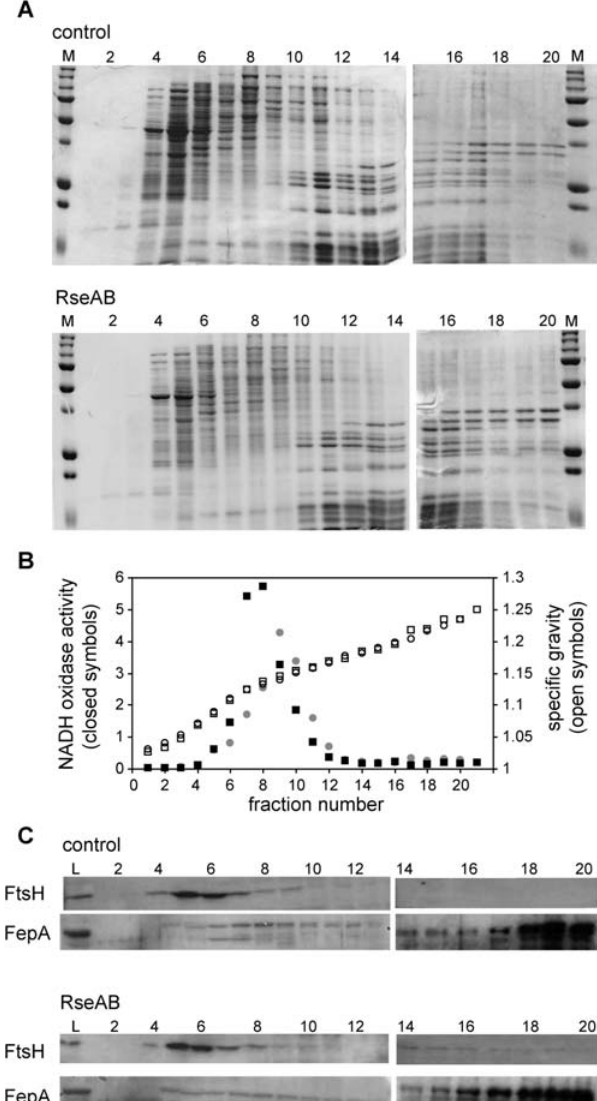
Figure 5. Fractionation of strain SEA007 lysates with and without inhibition of s E on sucrose density gradients. At 2.5 hours following inhibition of s E , cells were harvested and lysates separated by discontinuous sucrose density gradient centrifugation. Lysates from comparable numbers of cells (as determined by OD 600 ) were loaded on the gradients. (A) Coomassie-stained 12% SDS- polyacrylamide gels of gradient fractions from the control culture (top) and culture in which s E activity was inhibited (bottom). M denotes molecular weight markers. (B) b -NADH oxidase activity (closed symbols) and specific gravity (open symbols) of the fractions in (A), inhibition of s E (circles) and control (squares). (C) Western blots using polyclonal antibodies to detect FtsH (inner membrane) and FepA (outer membrane) in fractions from (A), control (top panels) and inhibition of s E (bottom panels). L denotes whole-cell lysates before the outer membrane protein, FepA (Fig. 5C). Fractions containing inner membrane were also identified using a b -NADH oxidase activity assay (Fig. 5B). Thus, loss of s E activity does not result in gross defects in the steady-state protein composition or density of the inner and outer membranes.